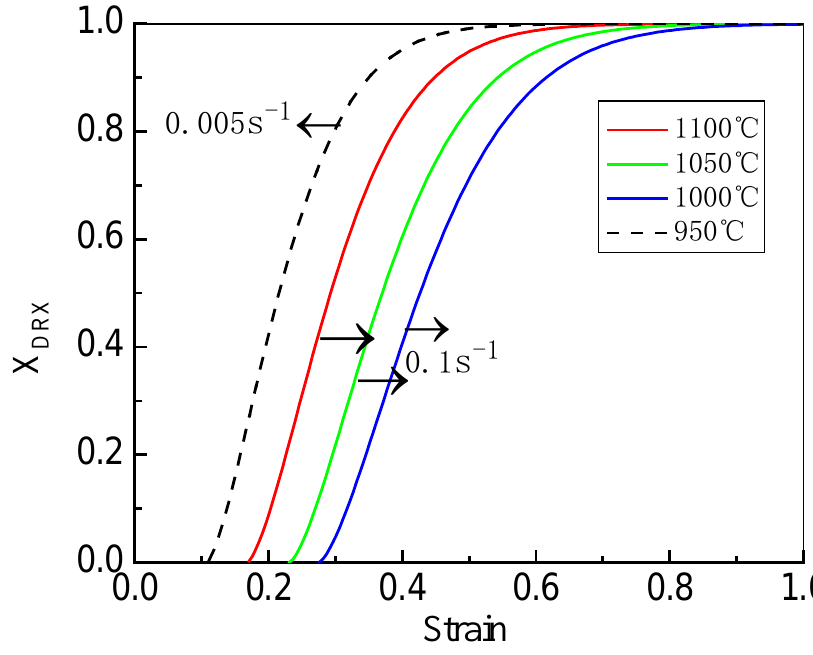
Figure 9. DRX kinetics curves for the examined steel at different temperatures and strain rates.